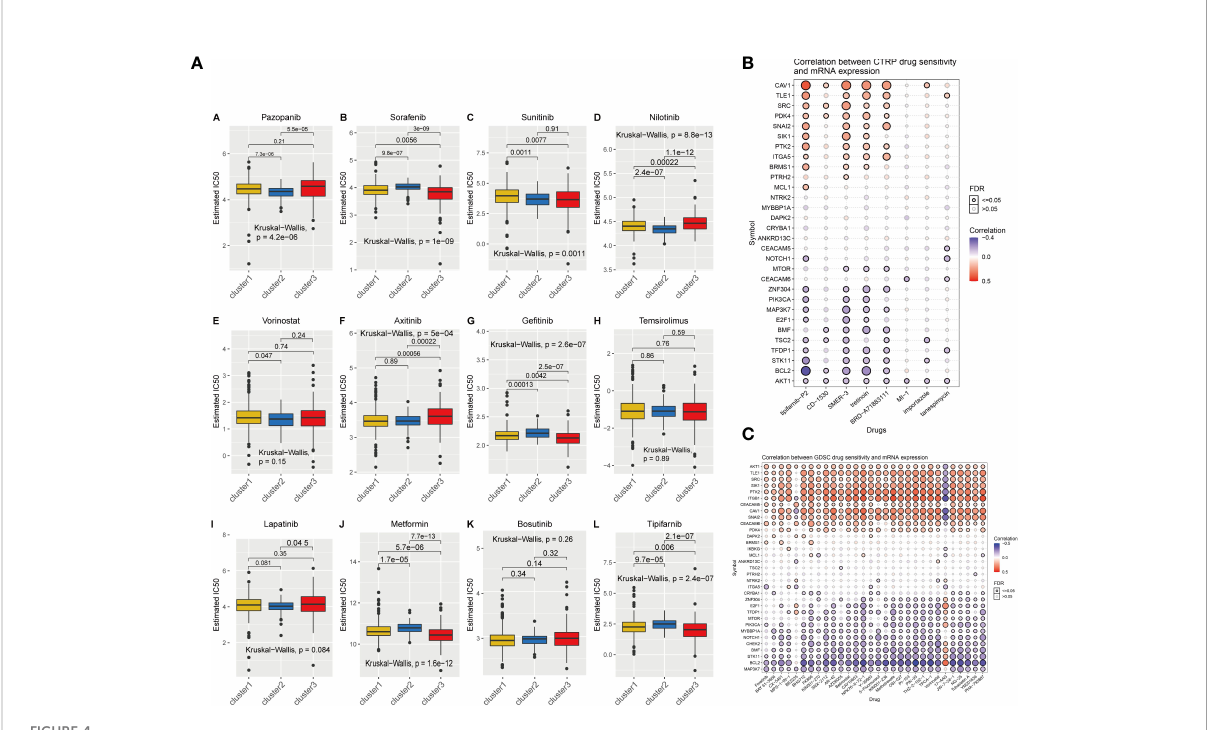
FIGURE 4 (A) The IC50 prediction of KIRC cells treated with a common tumor-targeted drug. C1, C2, and C3 indicate Cluster1, Cluster2, and Cluster3. (B, C) The correlation between the sensitivity of drugs results in various cancer obtained from the CTRP or GDSC database and the mRNA expression levels of anoikis-related